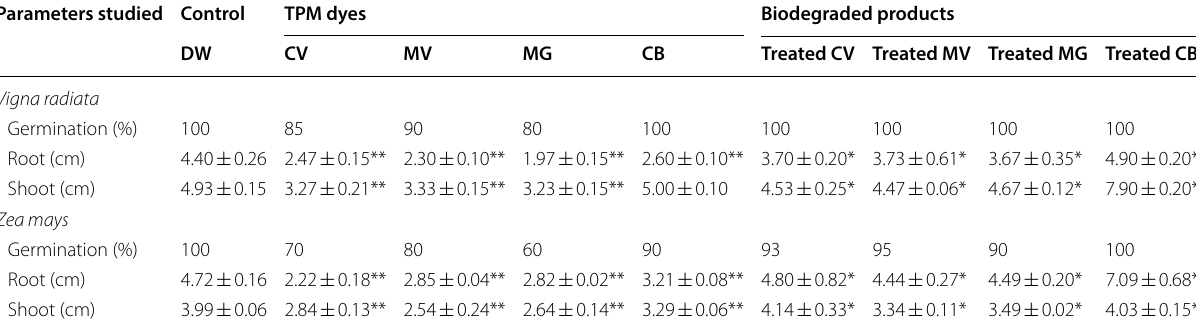
Values of root and shoot lengths are presented as mean of three experiments Root and shoot lengths of seeds grown in TPM dyes are significantly different from that of plants grown in sterile distilled water by ** p < 0.01, Root and shoot lengths of seeds grown in biodegraded products of TPM dyes are significantly different from that of plants grown in TPM dyes by * p <